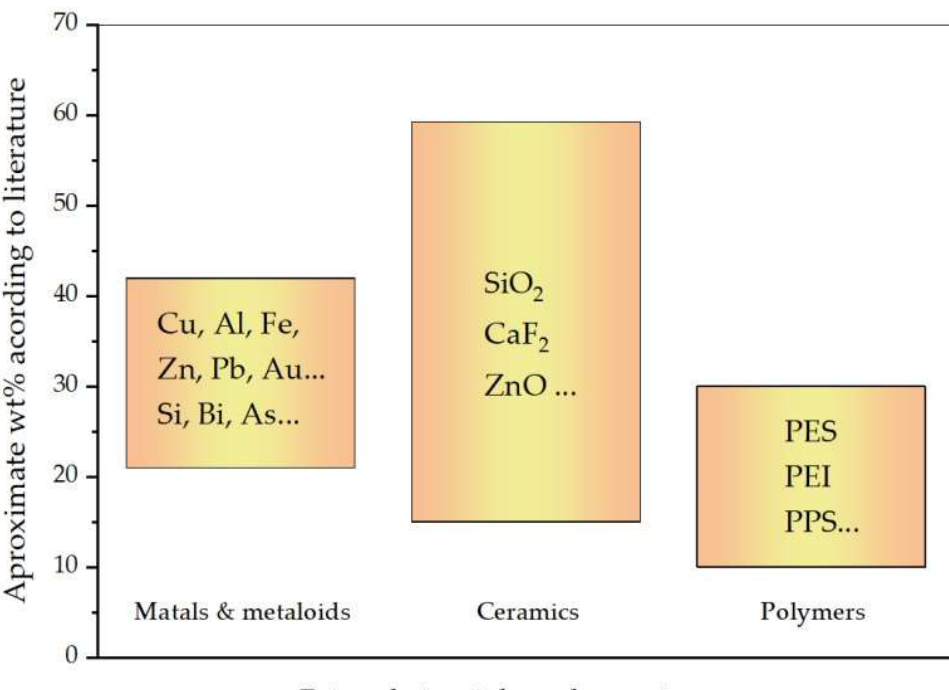
Figure 1. Range of printed circuit board constituents with their possible material content.